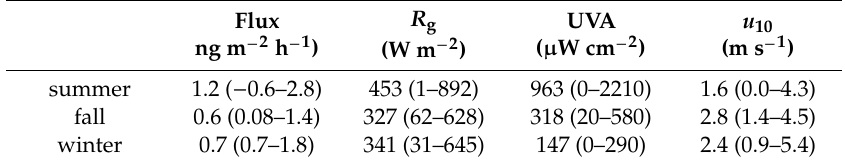
Figure 1. ( a ) Hg air/water exchange fluxes observed at Cane Creek Lake (TN, USA) from June to April and ( b ) the corresponding meteorological data measured simultaneously ( R g : global solar radiation, T w : water temperature, u 10 : wind speed). Table 3. Seasonal variation of the Hg air / water exchange fluxes and meteorological parameters obtained at Cane Creek Lake (TN,